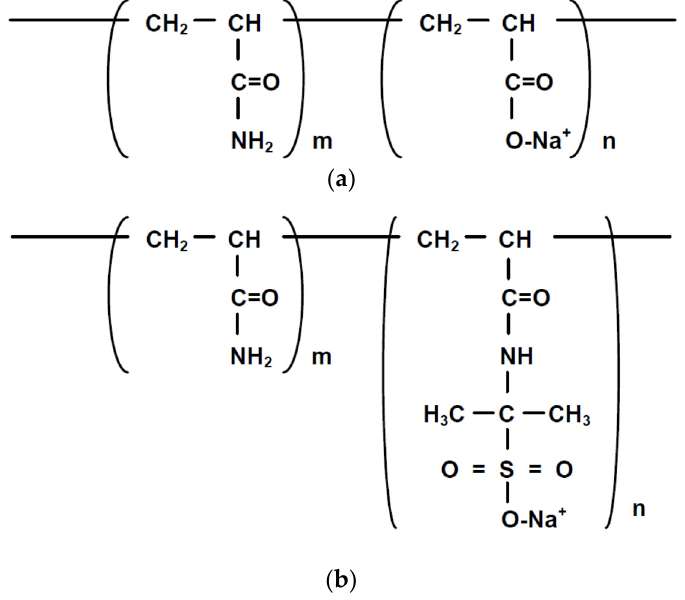
Figure 1. Molecular structure of each polymer type. ( a ) HPAM: hydrolyzed polyacrylamide; ( b ) AMPS: 2 ‐ acrylamido ‐ 2 ‐ methylpropane ‐ sulfonate copolymer.